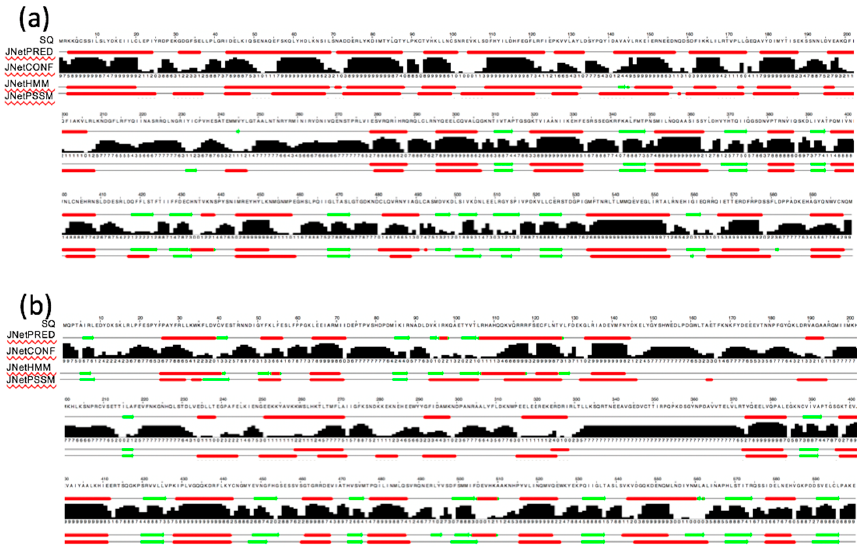
Figure 2. Predicted secondary structures of the 600-amino acid N-terminal sequences of Caenorhabditis elegans Dicer-related helicases (DRHs). The 600-amino acid N-terminal sequences of DRH-1 ( a ) and DRH-3 ( b ) were analyzed using the JPred4 server [20] to obtain the predicted secondary structures. SQ: amino acid sequence and the position from the N-terminus. Red tubes and green arrows in the predictions of JNetPRED (the consensus prediction), JNetHMM (hidden Markov model profile-based prediction), and JNetPSSM (position-specific scoring matrix-based prediction) indicate α -helices and β -sheets, respectively. JNetCONF indicates the confidence estimate for the prediction. High values and histograms shown in black indicate high confidence.